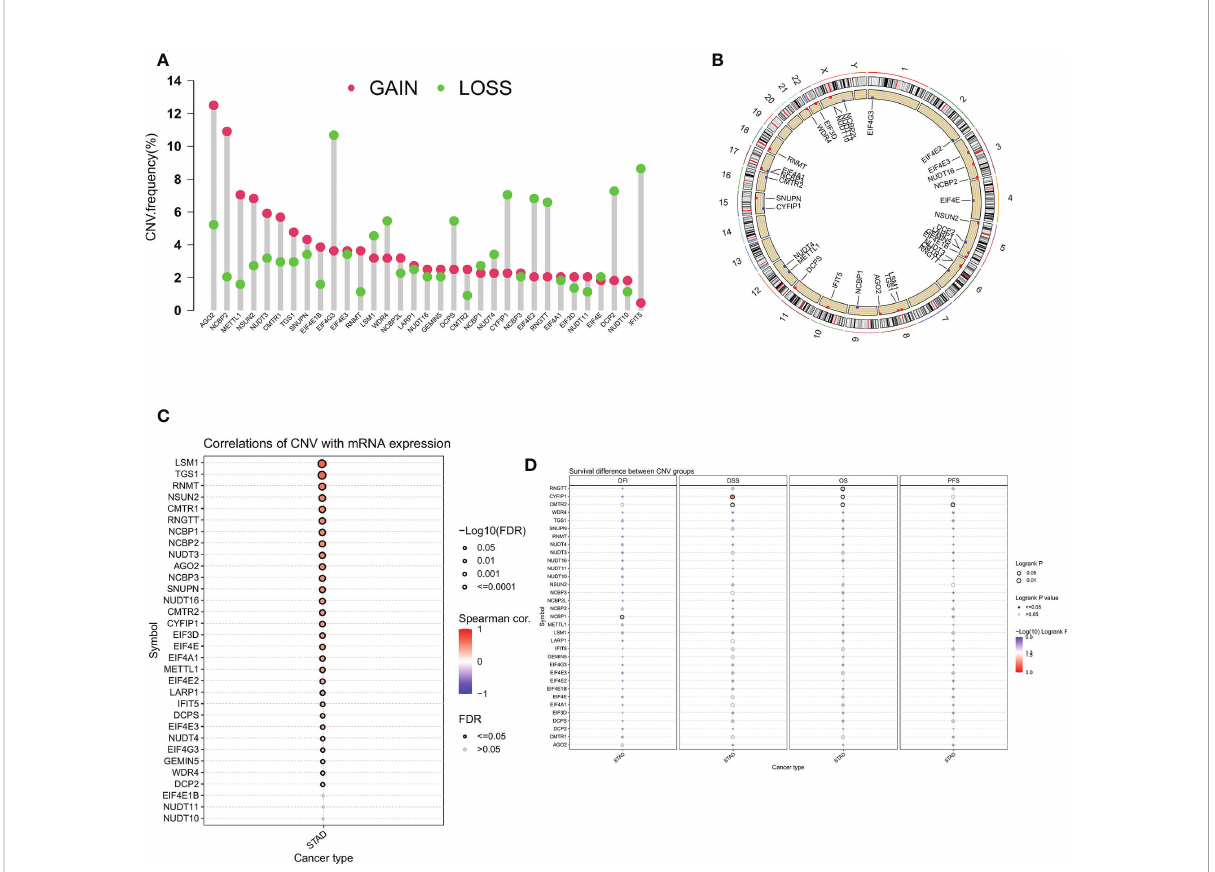
FIGURE 3 (A) Frequency of CNV change for m7GRGs. Red dots indicate CNV increase and green dots indicate CNV decrease. (B) The location of CNV alterations of m7GRGs on 23 chromosomes. Association of CNV alterations in m7GRGs with gene expression (C) and patient prognosis (D) . CNV, Copy number